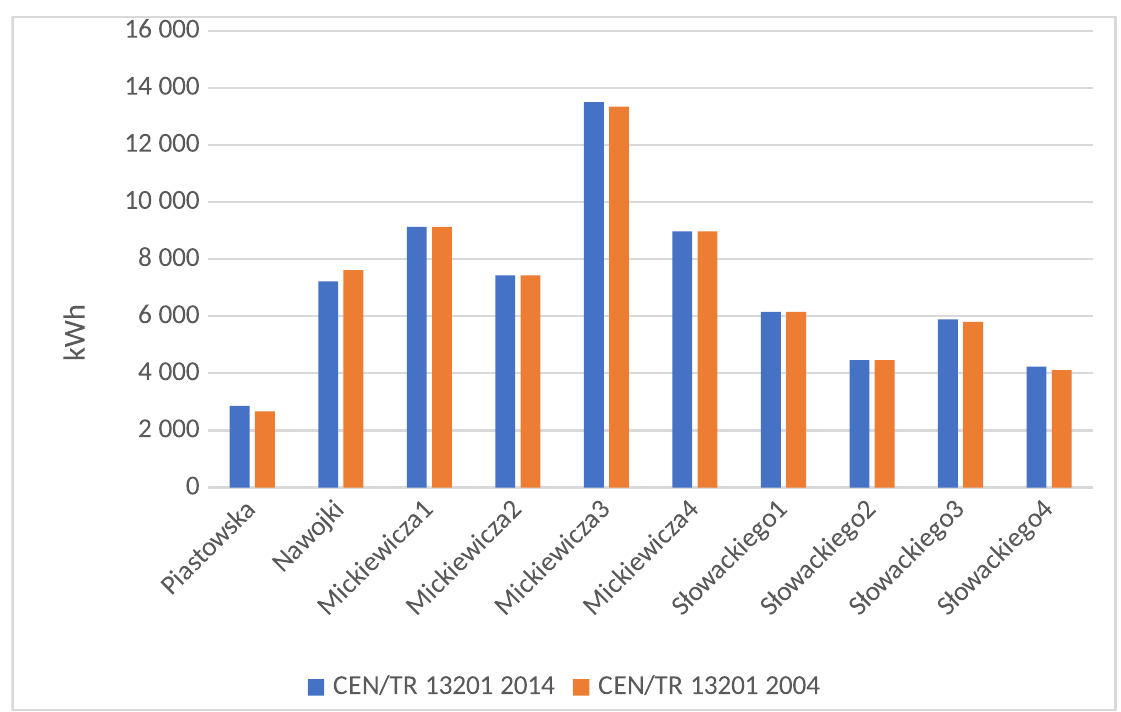
Figure 3. Static energy consumption comparison, CEN/TR 2004 vs.